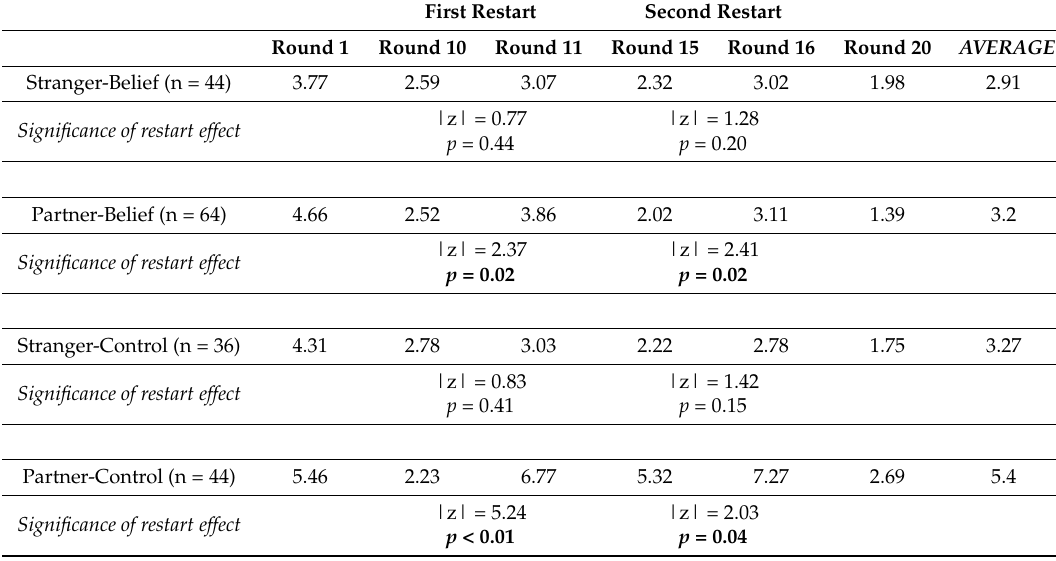
Table 2. Average token contribution to the public account over rounds in the four